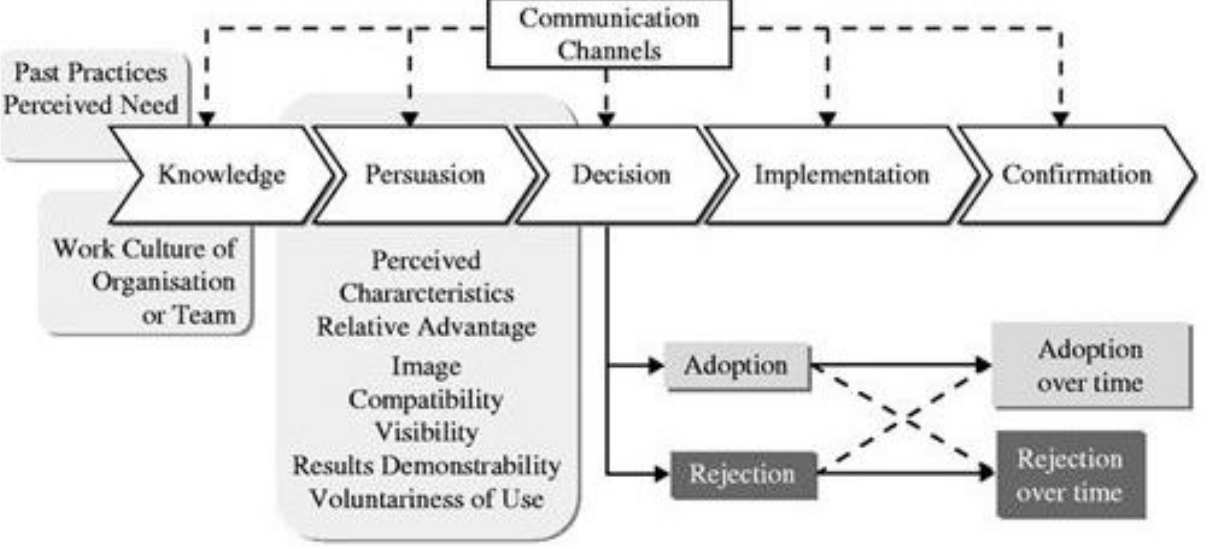
Figure 2: A model of the stages in the innovation-decision-making process. ‘The innovation-decision process is the process through which an individual (or other decision-making unit) passes from first knowledge of an innovation, to forming an attitude towards the innovation, to a decision to adopt or reject, to implementation of the new idea, and to confirmation of this decision’ (source: (Rogers